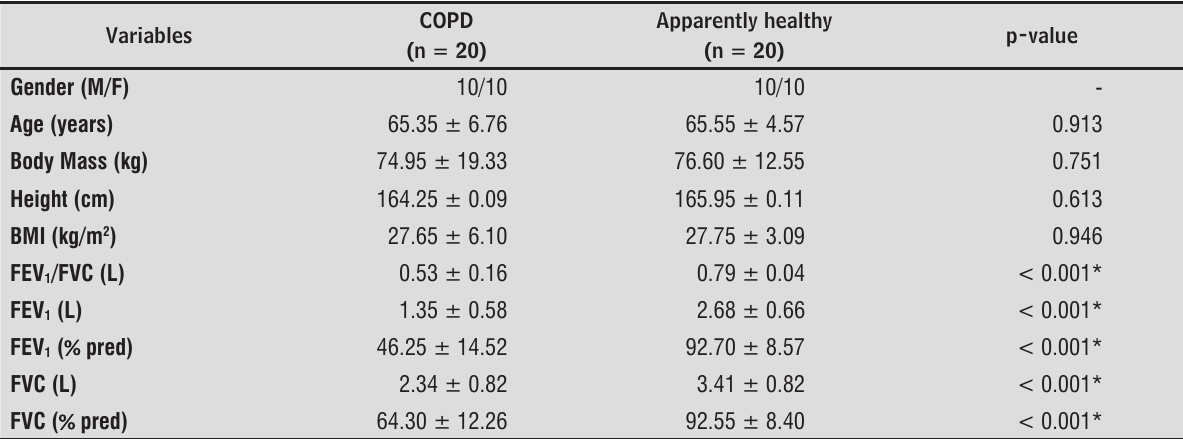
Table 1 - Characteristics of the studied groups (n = 40) Variables